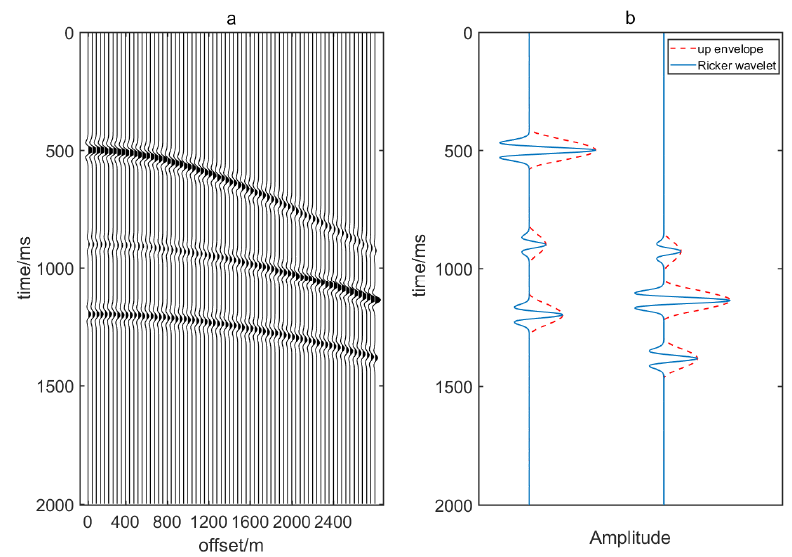
Figure 3. ( a ) Synthetic CMP gather; ( b ) the waveform and upper envelope.